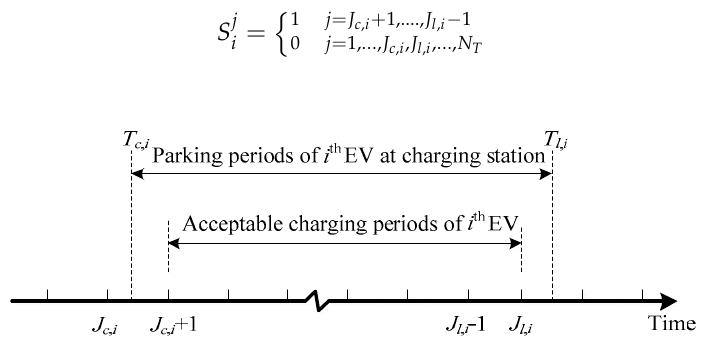
Figure 4. Diagram of acceptable charging periods.